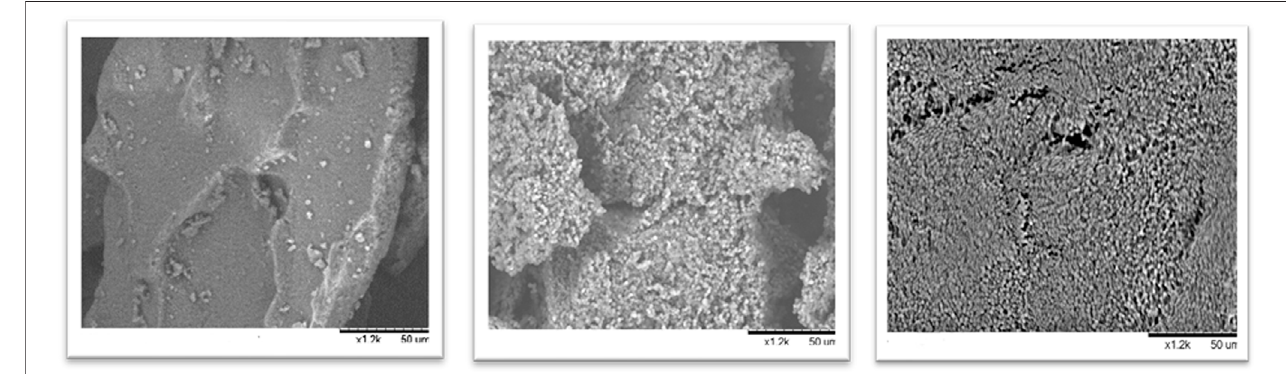
FIGURE 8 | N. gaditana biomass studied by SEM: initial time, up and left; pretreated biomass using soluble enzymes, up and right; and pretreated biomass using CLEAs ethanol at 90%,